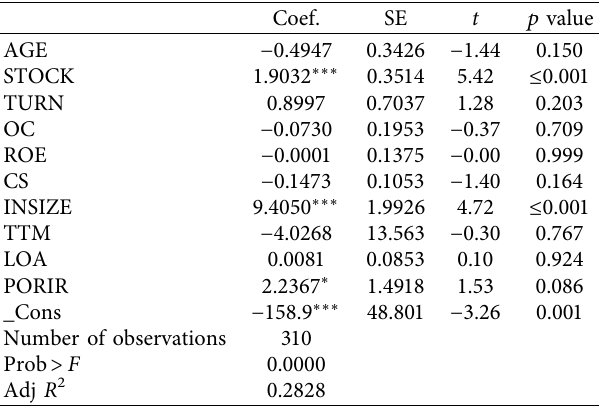
Table 7: Results of multiple linear regression of factors affecting the investment amount of government guiding funds.